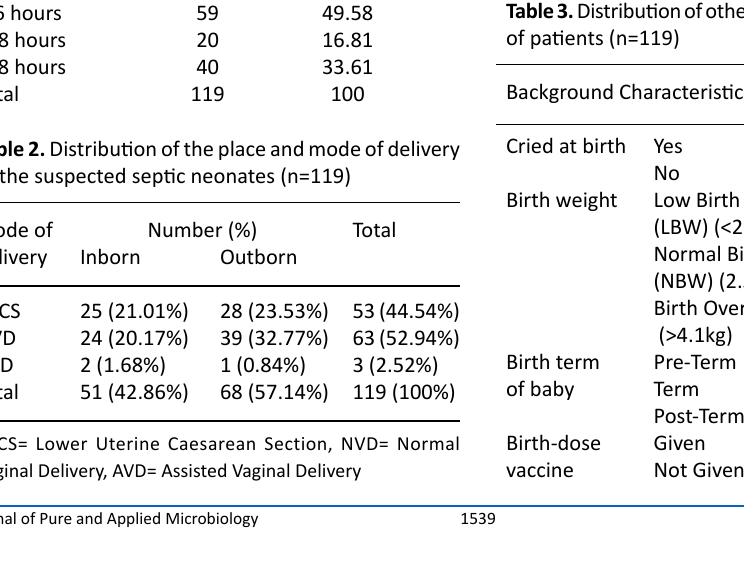
Table 3. Distribution of other background